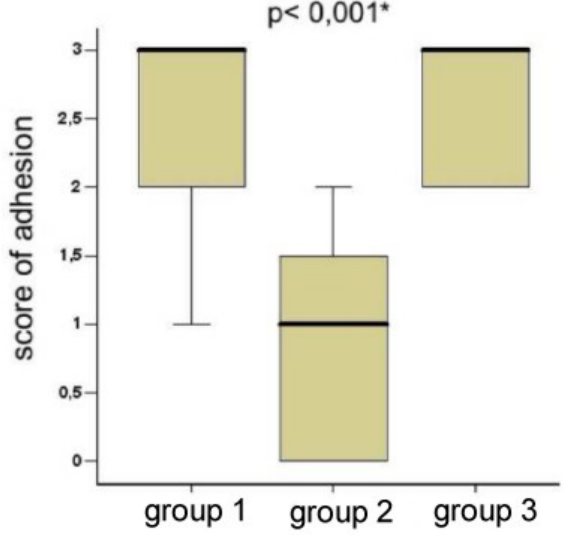
FIGURE 4 - Comparison of the rates of adhesions. * Difference between Group 2 and Groups 1 and 3 is statistically significant (p<0.001)